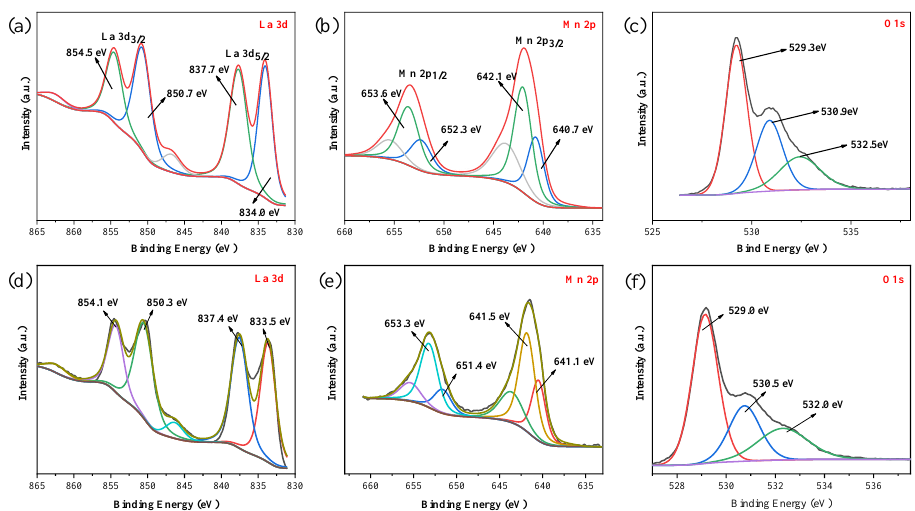
Figure 8. XPS of LMO/CN-10 before ( a – c ) and after ( d – f ) four cycles of TC degradation.